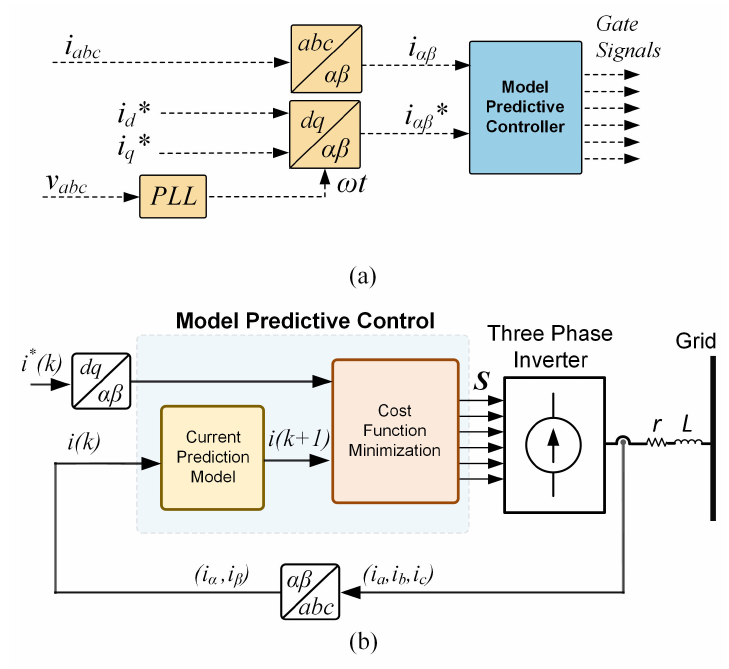
Figure 5. Model predictive controller. ( a ) Schematic diagram. ( b ) detailed